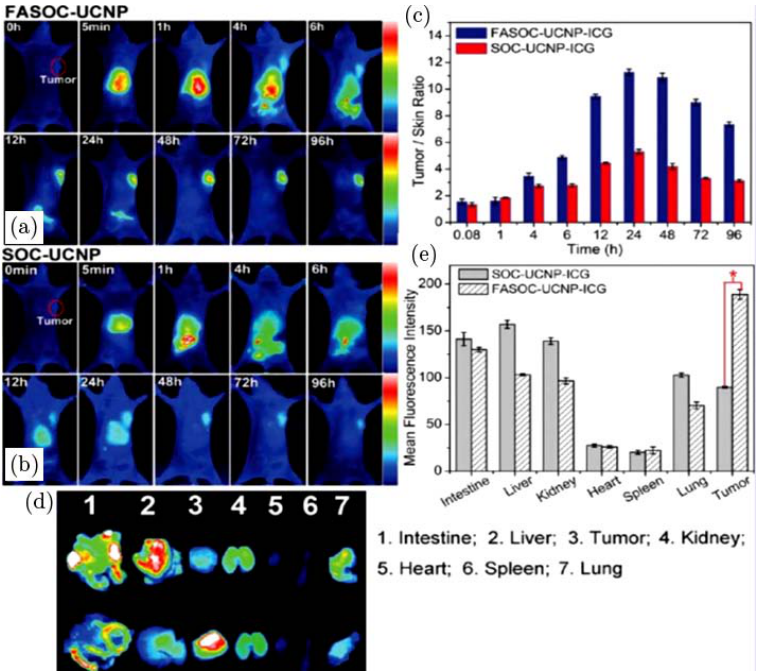
Fig. 6. In vivo tumor-targeting of the nanoconstructs. Fluorescence images of nude mice bearing Bel-7402 tumors with intrave- nously injection of (a) FASOC – UCNP – ICG and (b) SOC – UCNP – ICG; (c) tumor/skin ratio of tumor-bearing mice injected with di®erent nanoconstructs; (d) °uorescence images of isolated organs separated from Bel-7402 tumor-bearing mice in di®erent groups at 24 h postinjection; (e) semiquanti¯cation of FASOC – UCNP – ICG and SOC – UCNP – ICG in the isolated organs of mice with di®erent injection. (Reprinted with permission from \ in vivo targeted deep-tissue photodynamic therapy based near-infrared light triggered upconversion nanoconstruct". Copyright (2013) American Chemical